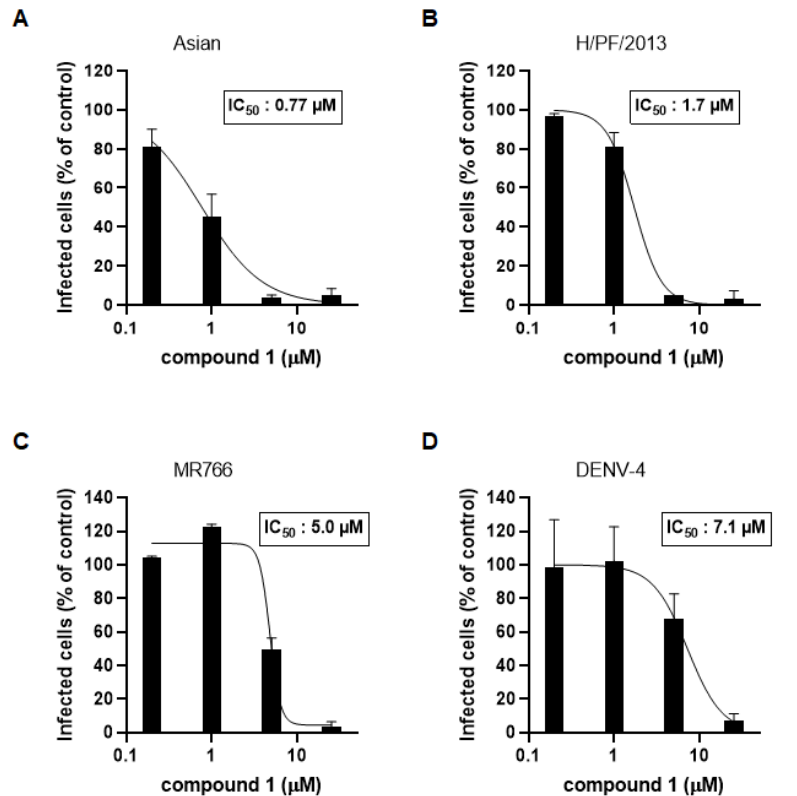
Figure 4. Compound 1 potently inhibits the infection of Huh7 cells by diverse strains of ZIKV and dengue virus type 4 (DENV-4, NCCP43257). Huh7 cells were treated with increasing concentrations of compound 1 and infected with ZIKV (strain: Asian) ( A ), (strain: H/PF/2013) ( B ), (strain: MR766) ( C ), and DENV-4 ( D ). A similar analysis to that shown in Figure 3A was performed.